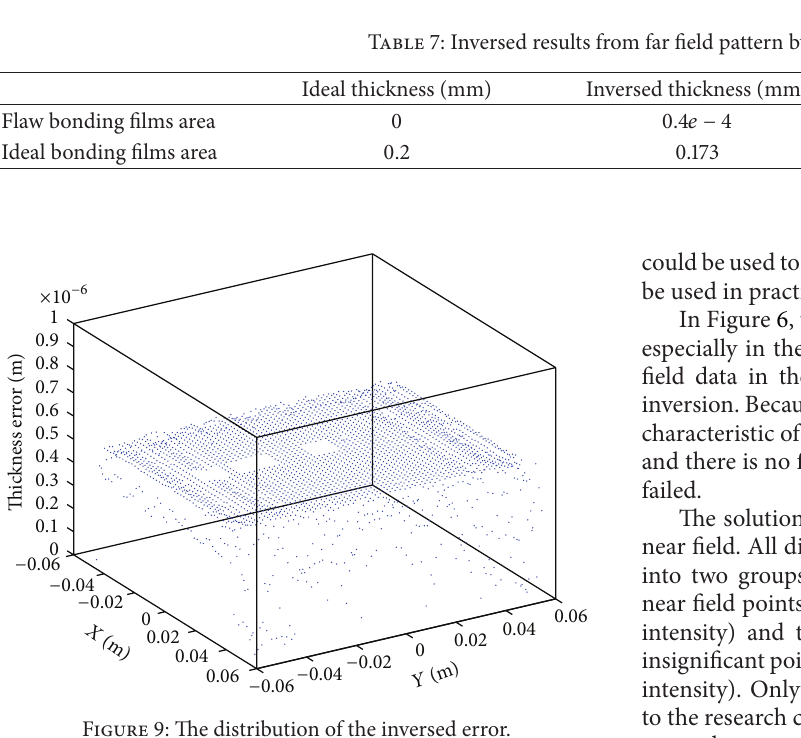
Figure 9: The distribution of the inversed